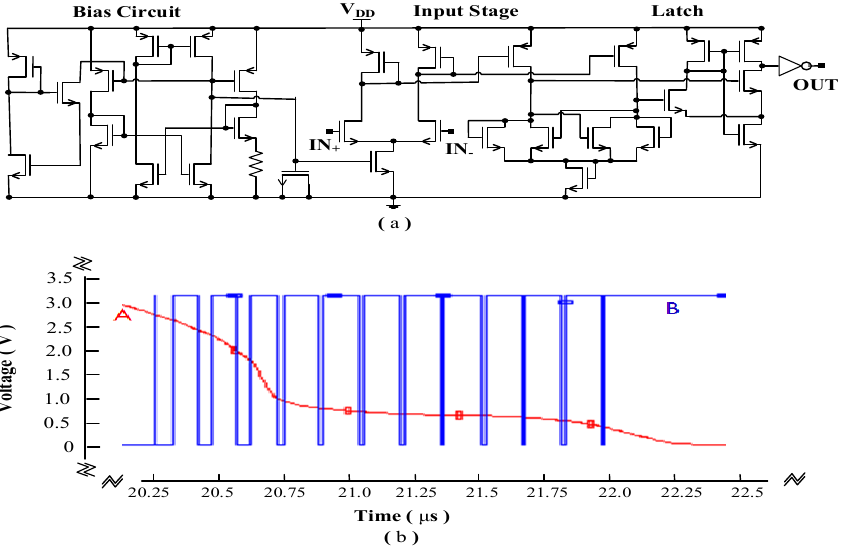
Figure 4. Proposed comparator circuit: ( a ) comparator circuit; ( b ) outputs of the op-amplifier (A) and comparator (B).